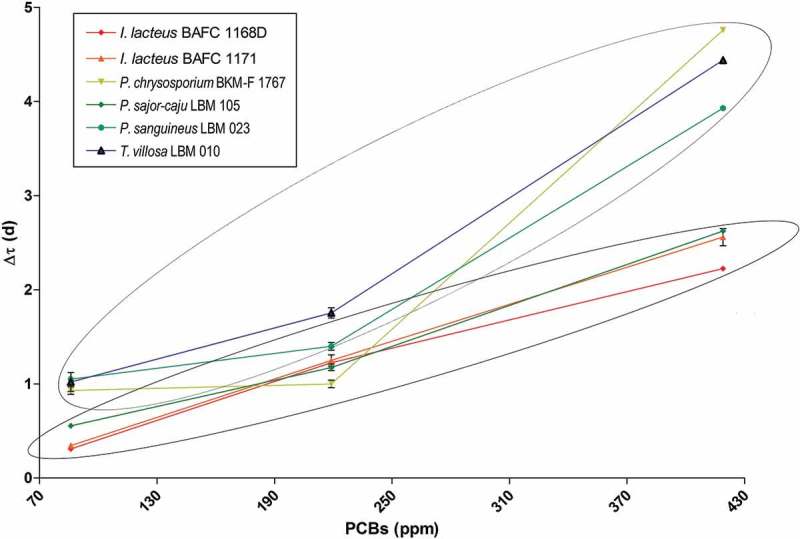
Δτ determination at three different PCB concentrations and identification of two homogenates fungal groups with p < .05.